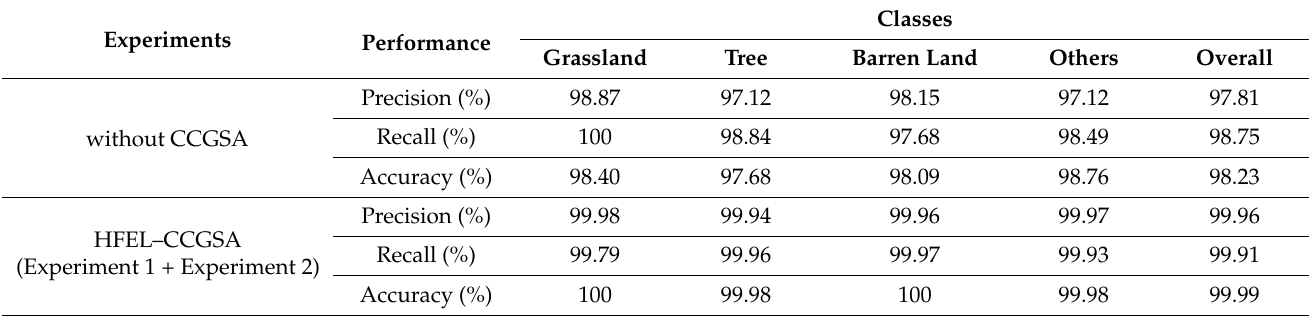
Table 1. Performance analysis for ‘without CCGSA’ and HFEL–CCGSA method on SAT-4 dataset. Experiments